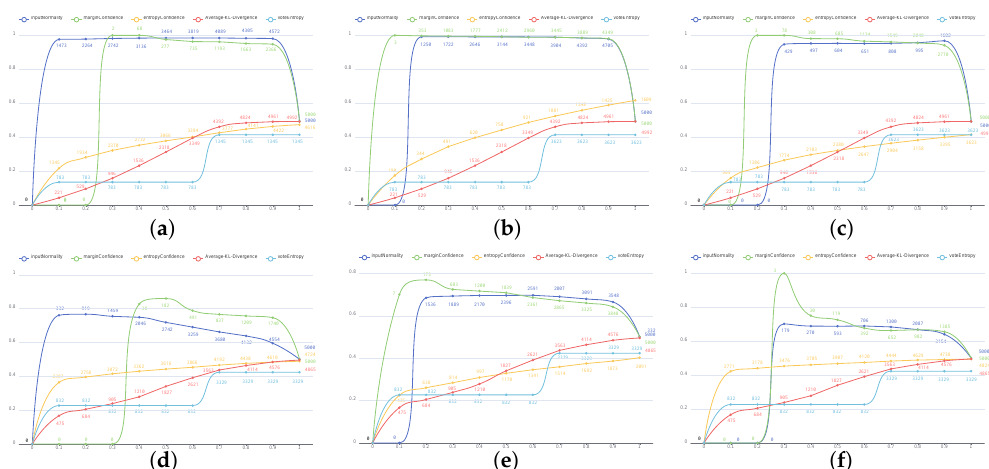
Figure 10. Comparing our indicator with active-learning indicators in identifying abnormal samples. The indicator score gradually increases along the X-axis in each figure, while the Y-axis represents the proportion of abnormal samples in the filtered samples. Numbers on lines indicate the number of abnormal samples found at the corresponding indicator scores. ( a ) mnist × RESNET20. ( b ) mnist × VGG16. ( c ) mnist × AlexNet. ( d ) cifar10 × RESNET20. ( e ) cifar10 × VGG16. ( f ) cifar10 ×